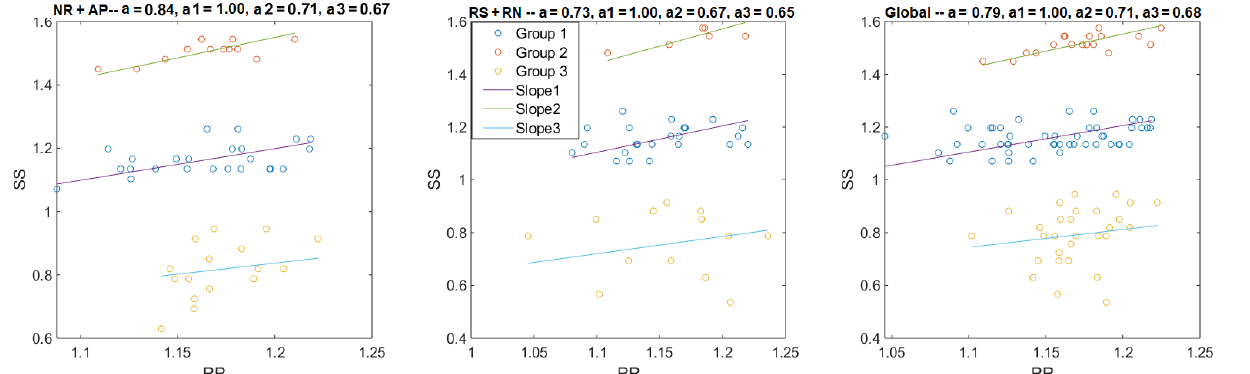
Figure 21. The left, middle, and right figures show the linear regressions for NR + AP, RS + RN, and the whole recording. The blue points are from the group of R-R vs. S1-S1 or S2-S2 (group 1, at the middle group of each figure), the orange points are from the group of R-R vs. S2-S1 (group 2, at the top of each figure), and the yellow points are from the group of R-R vs. S1-S2 (group 3, at the bottom of each figure). The slopes of each fit line are presented the in figure title ( a 1, a 2, and a 3 are slopes for the group 1, group 2, and group 3, respectively).